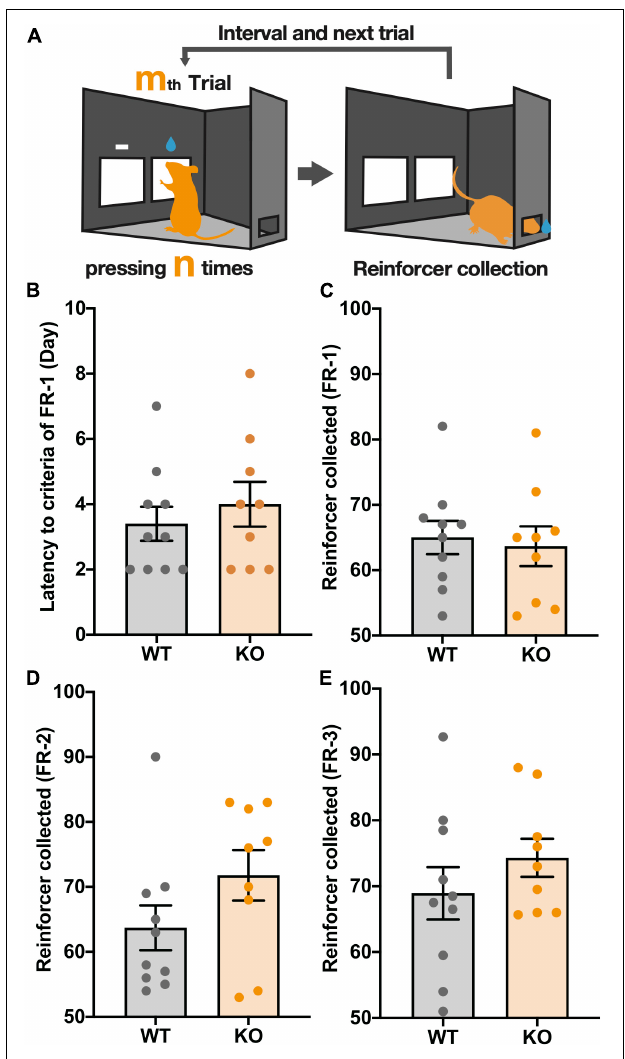
FIGURE 1 | KPNA3 KO mice show unaltered performance in a fixed ratio (FR) schedule test when compared with WT mice. (A) Illustration of The FR schedule test. The right panel is the correct panel and the left is the incorrect panel (left image). n is a fixed value, 1, 2, or 3. m is the order number of a trial. Following a correct response mice can collect a reward from the rear reward magazine (right image). (B) The Number of days until the FR-1 criterion was reached. (C–E) The number of rewards earned in sessions where the criterion was reached. The criterion for FR-1 and 2 was 50 reinforcers and FR-3 was 50 reinforcers on 2 consecutive days. Data represent the mean ± SEM, Student’s t -test (WT = 10, KO =